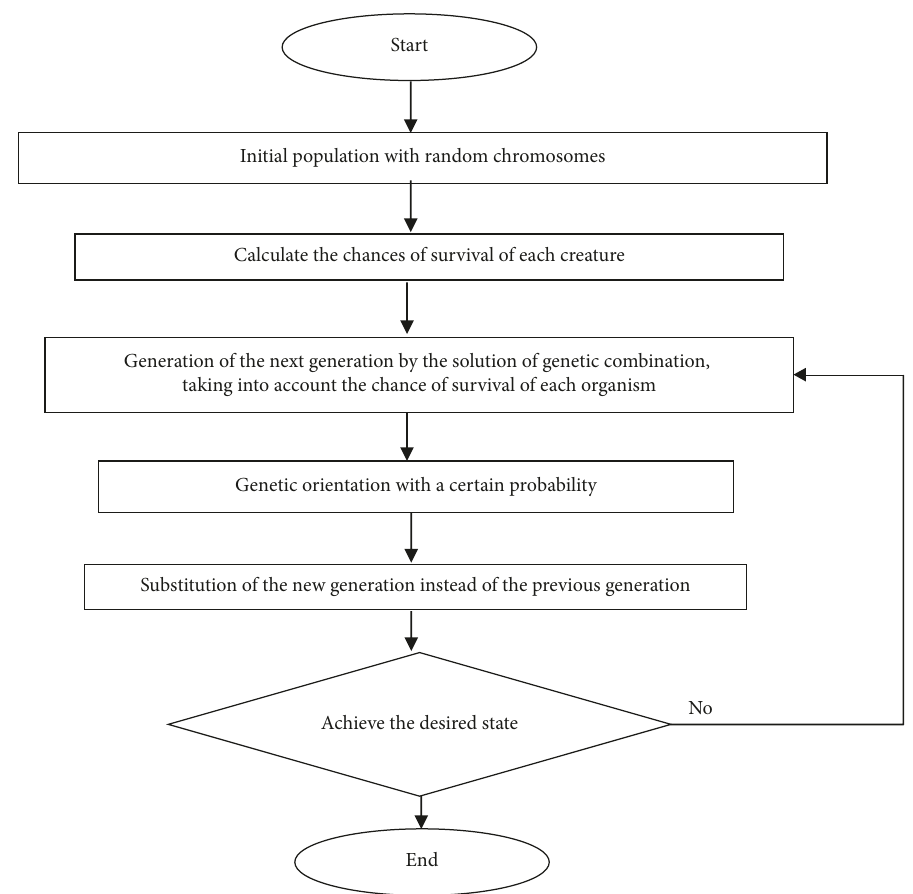
Figure 4: Solution steps in the genetic algorithm. Table 2: Comparison of the experimental data with simulation results